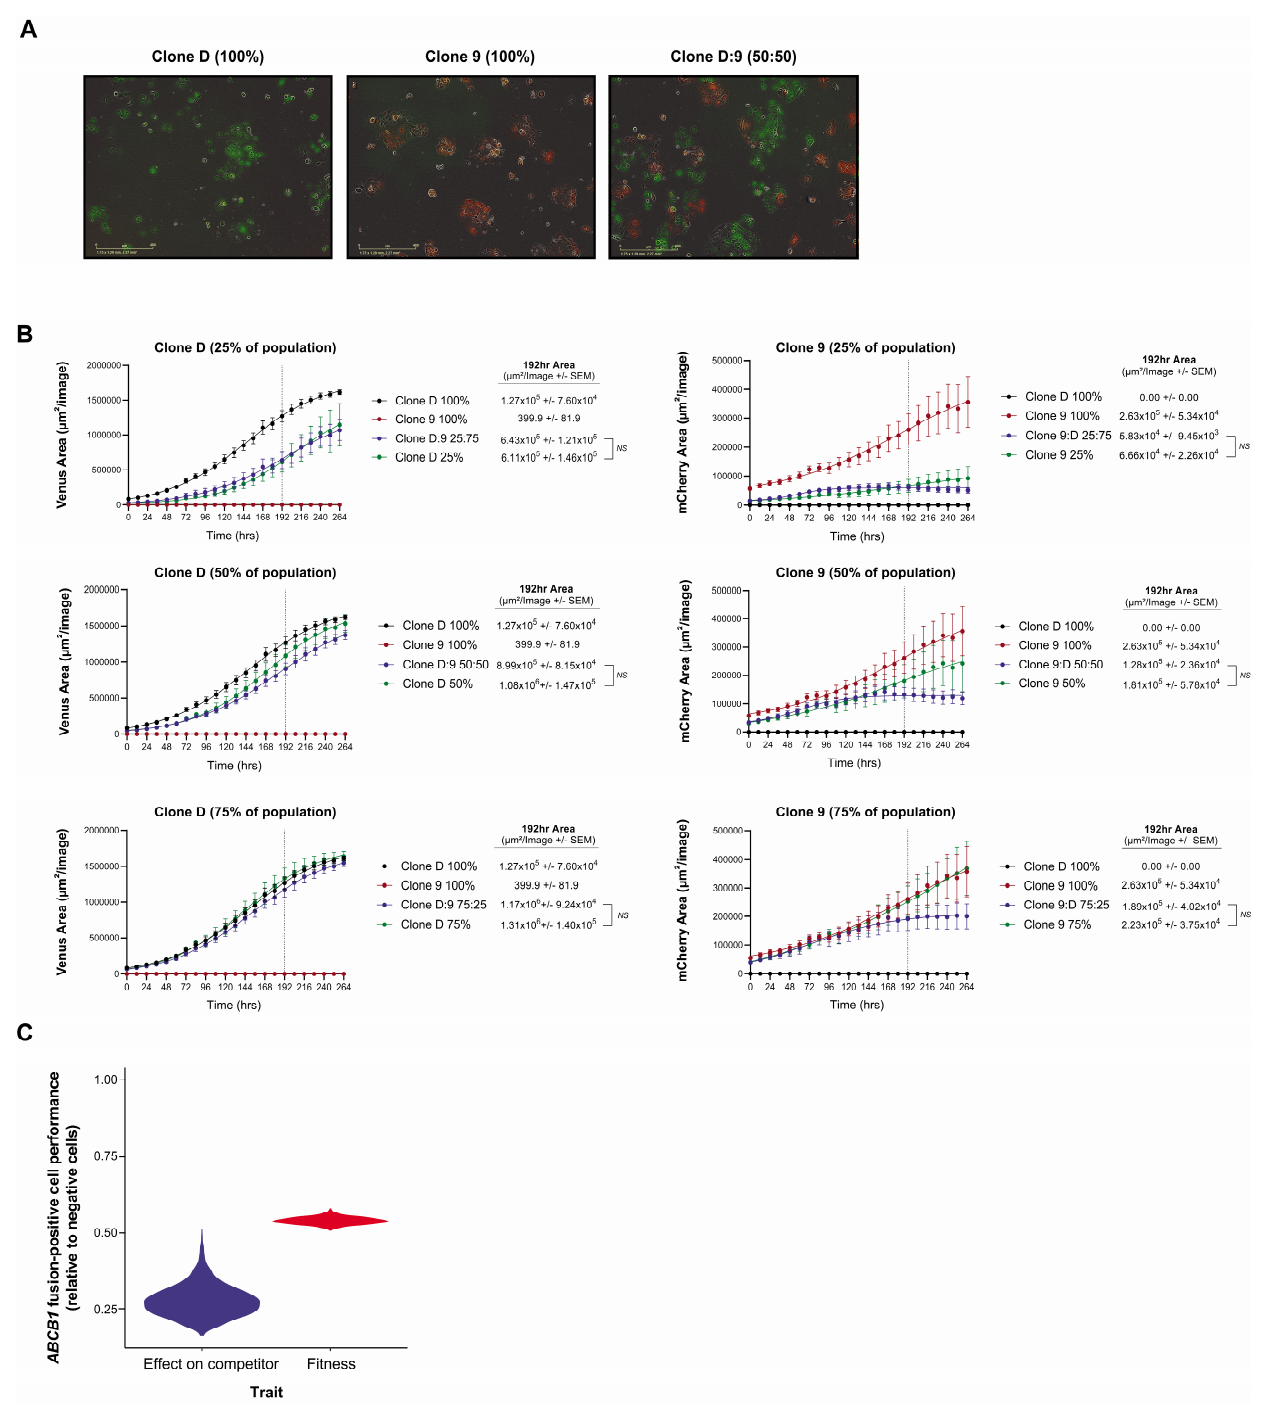
Figure 5. Competition model estimates of the relative fitness and competitive ability of fusion-positive versus negative counterparts. ( A ) Representative IncuCyte fluorescent images of Clone D (Venus Yellow) and Clone 9 (mCherry) LeGO transduced AOCS18.5 clones seeded in pure (100%) and mixed (50:50) ratios 48 h post seeding. ( B ) IncuCyte proliferation analysis of Clone D (Venus Yellow) and Clone 9 (mCherry) cells grown alone or in co-culture (25:75, 50:50 and 75:25 seeding ratios) for 264 h. Data represent mean fluorescent area ( µ M 2 /image) ± SEM from a minimum of 4 independent experiments. ( C ) Estimates obtained by fitting a Lotka–Volterra population growth model of competition to the growth curves of fusion- positive (Clone 9) and fusion-negative (Clone D) clones’ growth in mono- and co-culture. Violin distributions show the range of uncertainty in the relative performance of the resistant and sensitive cells. Values below the horizontal dashed line indicate a greater fitness and competitive effect of the sensitive ABCB1 fusion-negative